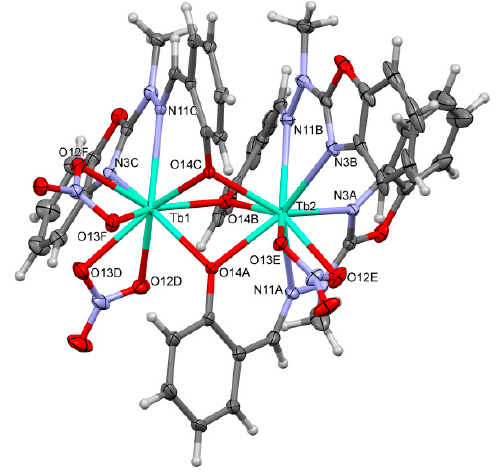
Figure 2. An example of the first of the two different types of structures A . A perspective view of the [Tb 2 (C 15 H 12 N 3 O 2 ) 3 (NO 3 ) 3 ] ( 3a ).